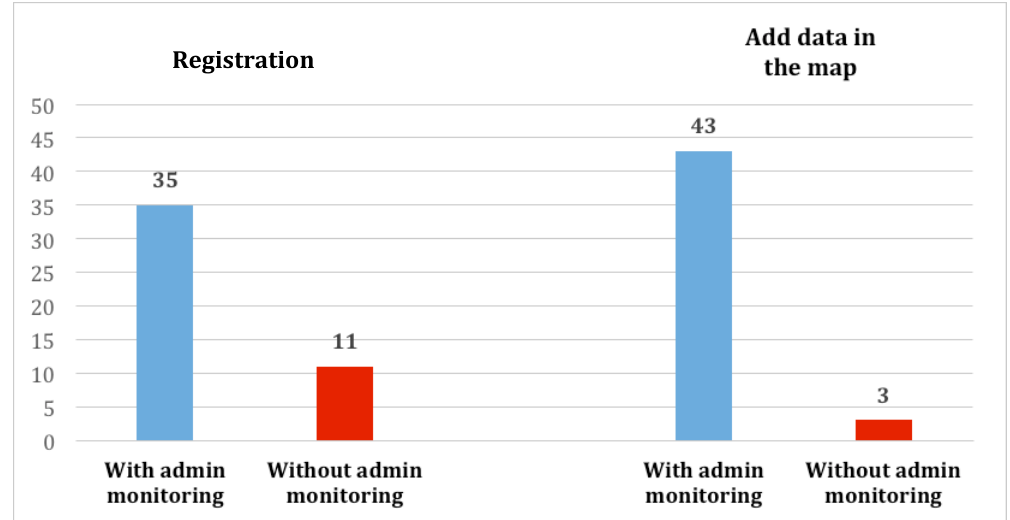
Figure 4. Choose the management options from the following that you believe are most appropriate.